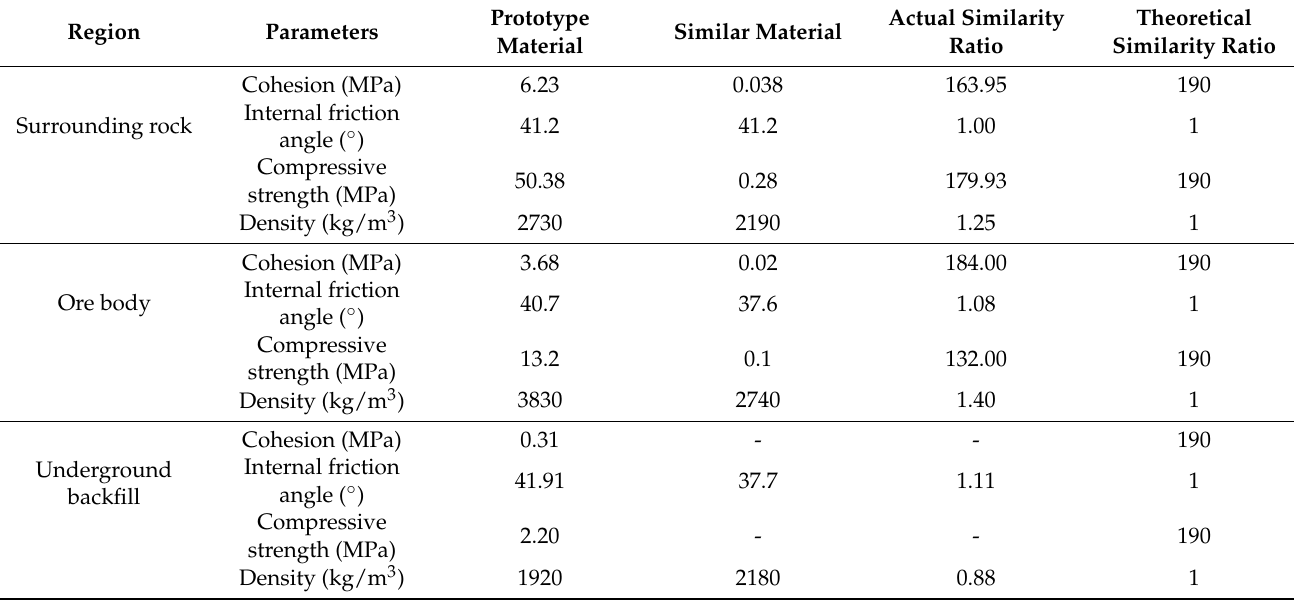
Table 4. Comparison of mechanical parameters of surrounding rock, ore body, underground backfill prototype materials, and similar